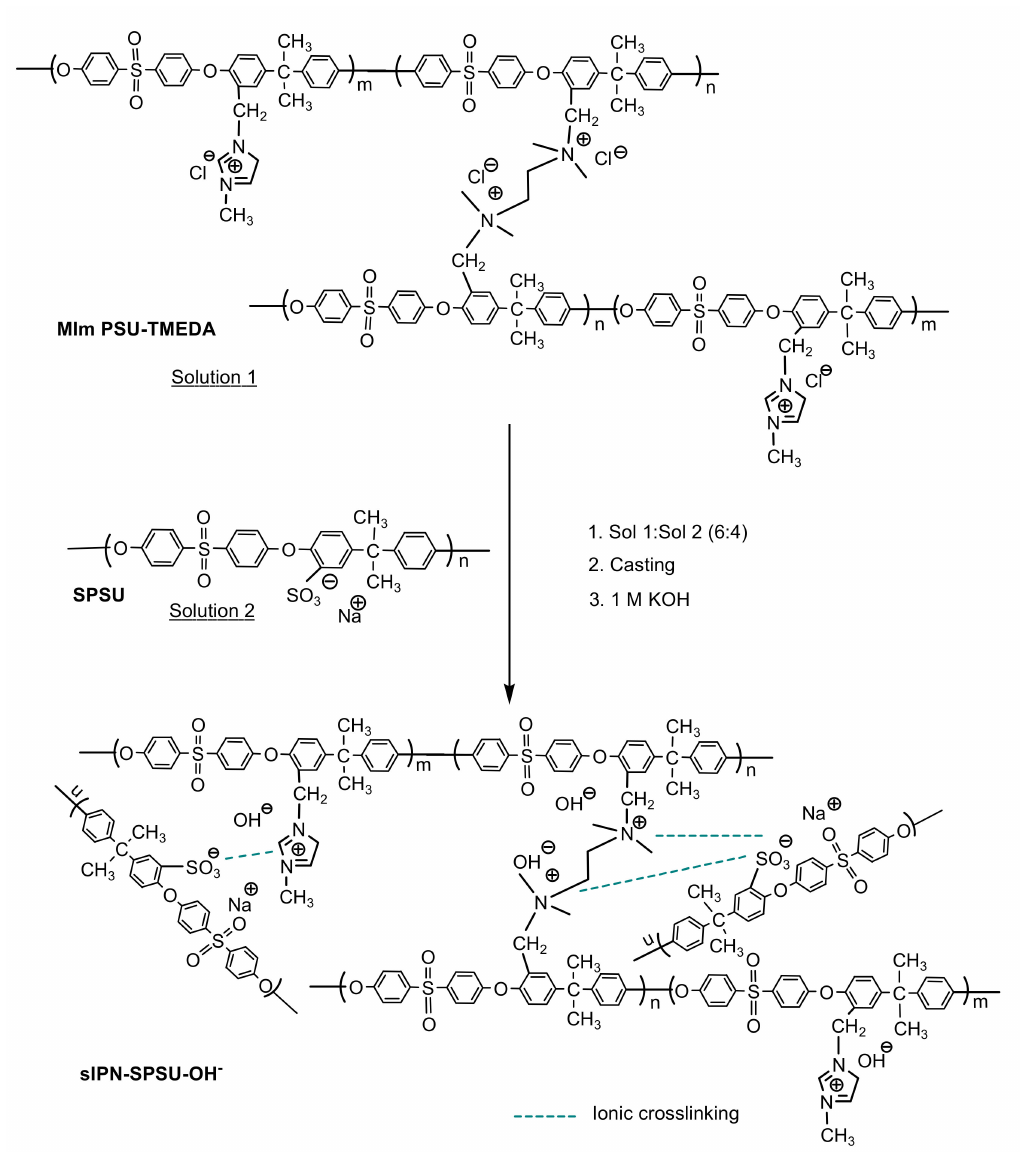
Figure 2. Synthesis of semi-interpenetrating polymer network (sIPN)-SPSU-OH −